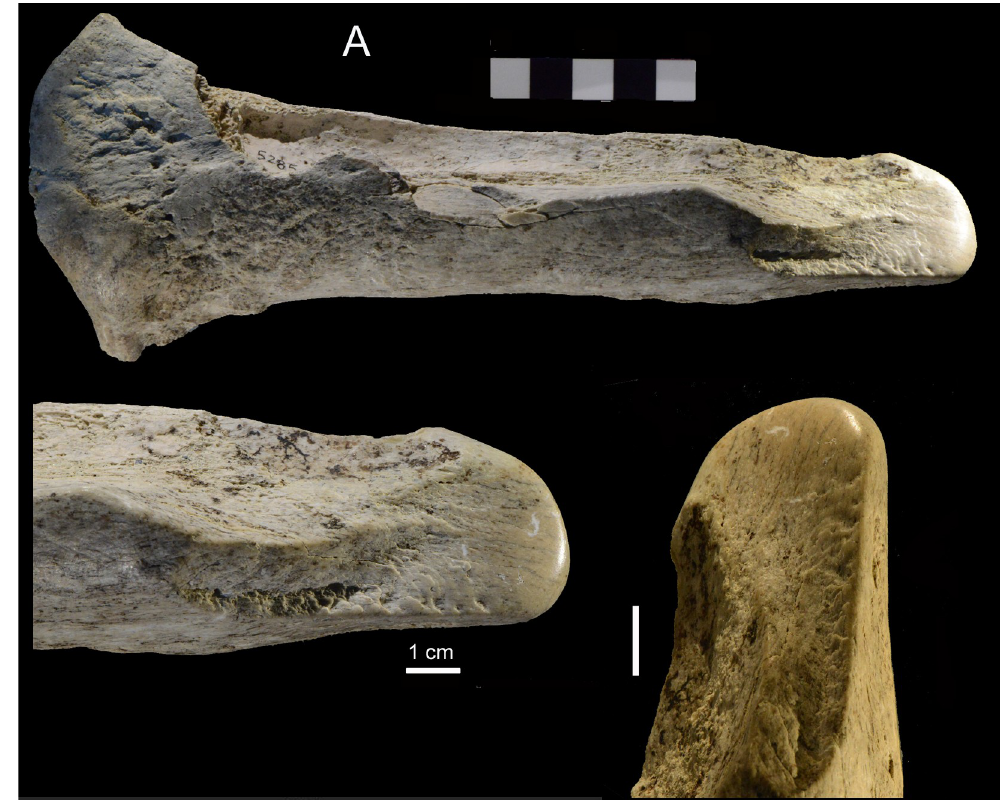
Fig 14. Castel di Guido, smoother. Right radius of Bos primigenius with polished tip, catalogue number 5285. Compare to Scho¨ningen 12 II-4c, equid radius with polished tip [17].